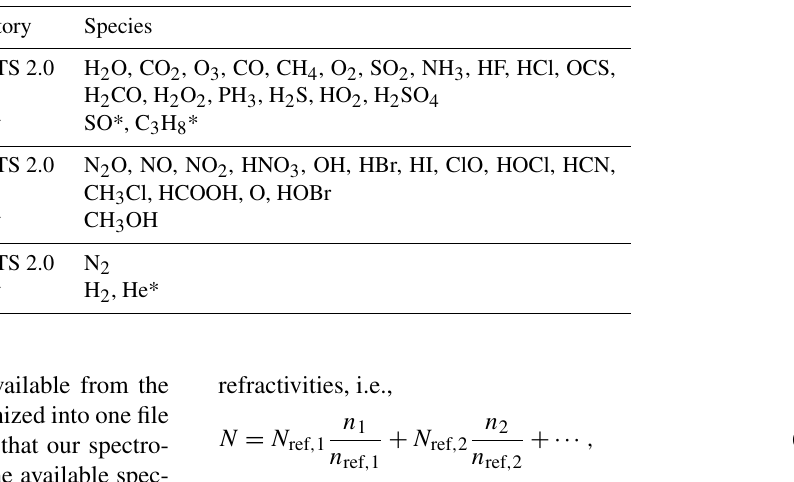
Table 4. Overview of the absorption species covered by the ARTS spectroscopic database. For “planet interest” species, ARTSCAT-4 type data with foreign species-specific line parameters have been compiled, while data for “Earth-only” species have been taken from HITRAN without modifications and are provided in ARTSCAT-3 format. Empty data files are provided for “no transition” species, which exhibit no absorption lines within the spectral region of interest of the planetary toolbox but have to be considered as perturbing species. Species with “ARTS 2.0” history are known species in ARTS’ pre-toolbox version. “New” species have been added in ARTS 2.2 with species data taken from HITRAN (default) or other sources like the JPL database (denoted by